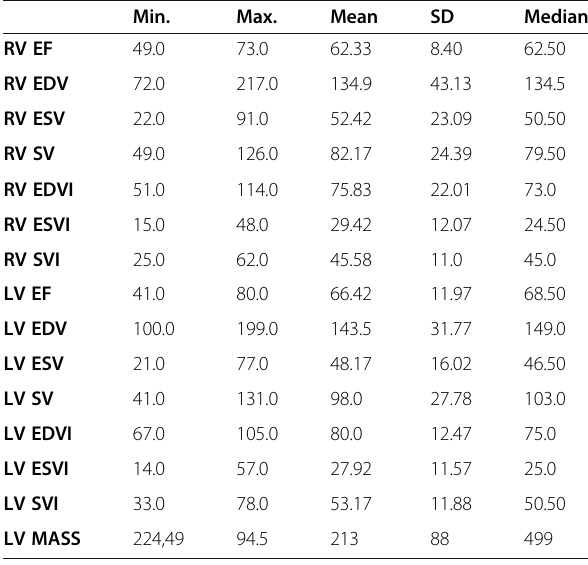
Table 4 Descriptive analysis of the studied cases according to different parameters in HCM diagnosis ( n = 12) Min.